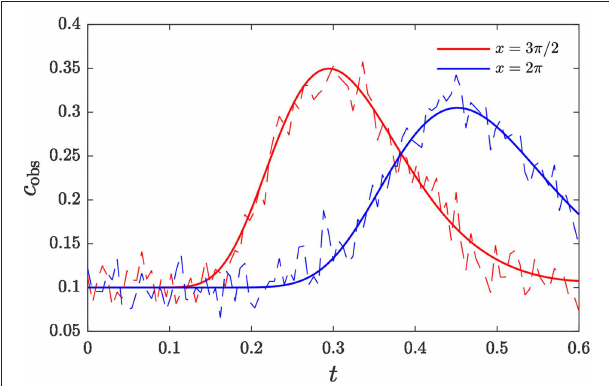
FIGURE 3 | Breakthrough curves of contaminant at observation locations along the transport domain. Noisy measurements used for inference are shown in dashed lines.